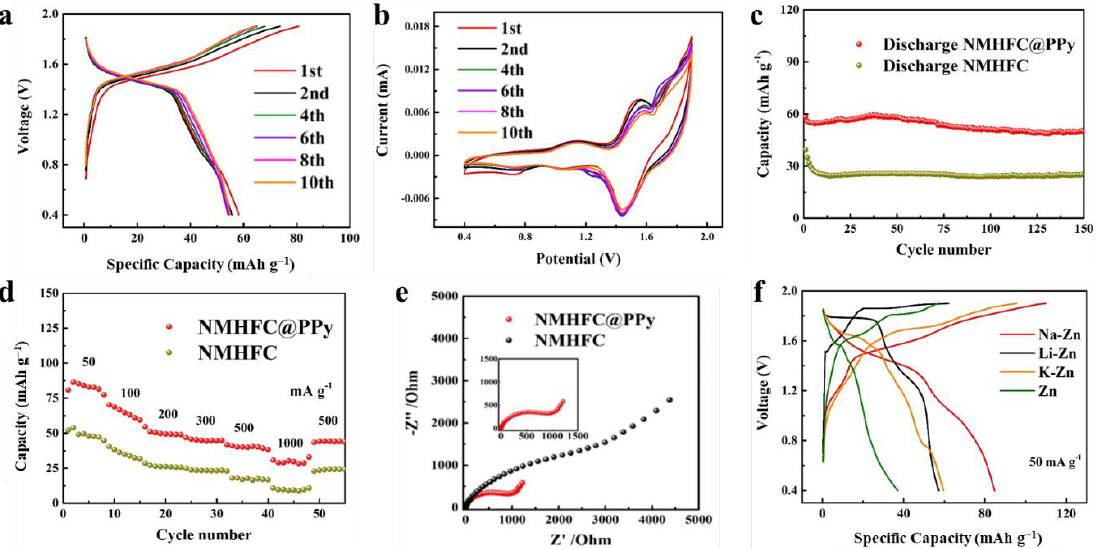
Figure 3. ( a ) Charge and discharge curves of NMHFC@PPy from first to tenth cycle at a current density of 200 mA g −1 ; ( b ) CV curves of NMHFC@PPy at a scan rate of 0.1 mV s −1 ; ( c ) long-cycle performance at 200 mA g −1 of NMHFC@PPy and NMHFC; ( d ) rate performance; ( e ) EIS tests of NMHFC@PPy and NMHFC; ( f ) charge and discharge curves in different electrolytes at a current density of 50 mA g −1 .